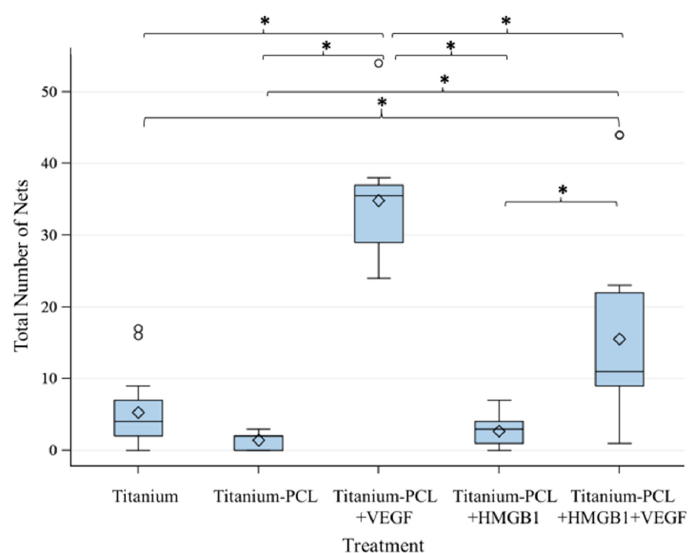
Figure 7. Number of Nets built by investigated implants. VEGF-functionalized titanium-PCL implants lead to significantly more building of net-like structures than all of the other titanium implants with or without cytokines in the assay. VEGF + HMGB1-functionalized titanium-PCL implants built significantly more nets than pure titanium implants, titanium-PCL implants and HMGB1-functionalized titanium-PCL implants. F-test from the analysis of variance followed by pairwise multiple means comparisons with the Least Significant Difference test were used ( p ≤ 0.05).